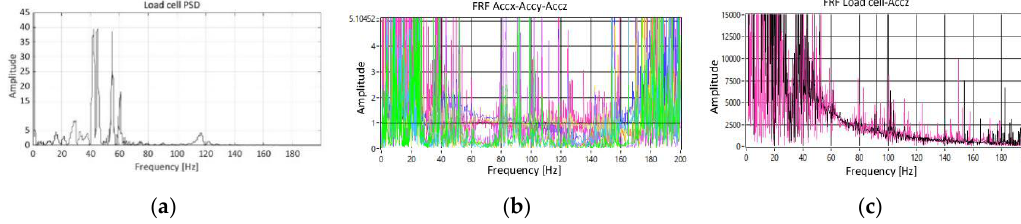
Figure 5. ( a ) PSD of the load cell signal; ( b ) FRF of the acceleration in the three directions; ( c ) FRF of the load cell and of the vertical acceleration signals.